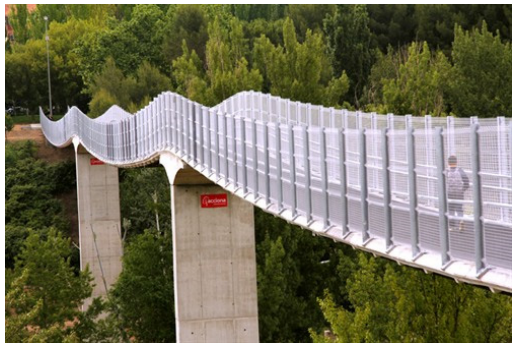
Figure 4. Stress ribbon footbridge in Cuenca, Spain (photo by ACCIONA [19]).